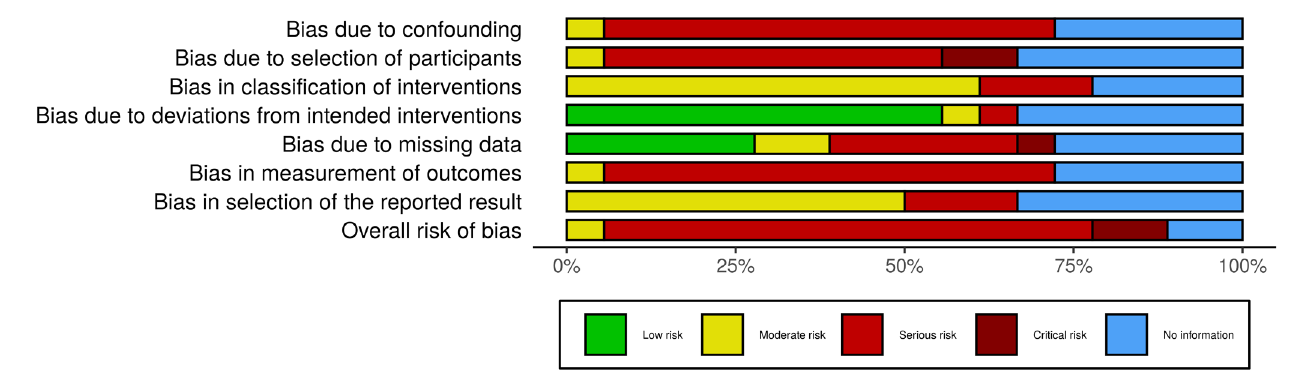
Fig. 2 - Risk of bias in